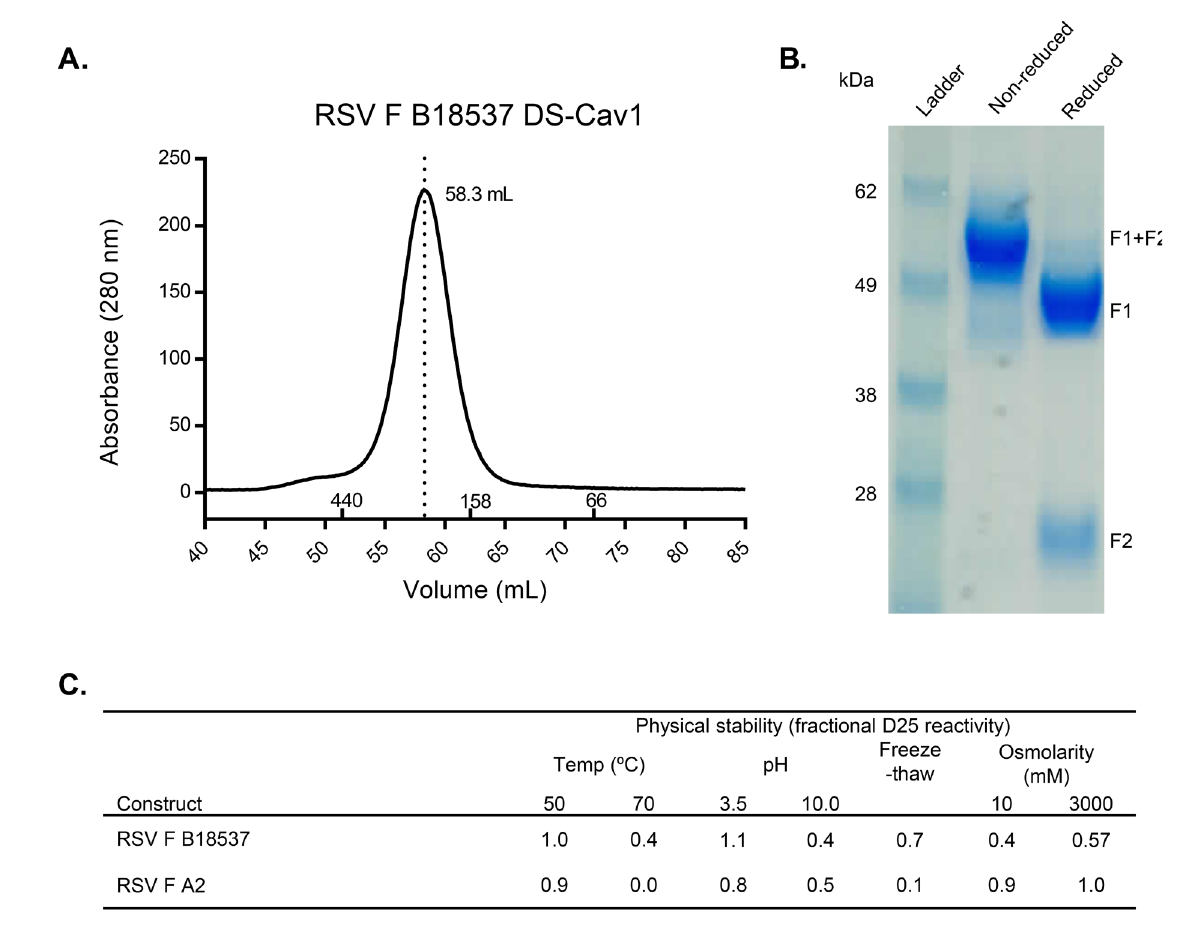
Supplementary Figure 1. Purification of RSV strain B18537 DS-Cav1 F glycoprotein. (A) Size-exclu- sion chromatograph of RSV B18537 F glycoprotein in PBS buffer on a 120 mL Superdex-200 gel filtration column. Elution volume of protein standards with known molecular weights are indicated along the base of the chromatogram. (B) SDS-PAGE of the peak fraction from size-exclusion chromatography. (C) Phys- ical stability of RSV B18537 F glycoprotein in comparison with those of RSV subtype A F. Physical stabil- ity was measured by the fractional value of the D25 reactivity retained after exposure to various physical extremes, compared with the initial D25 reactivity, as determined by Octet biolayer